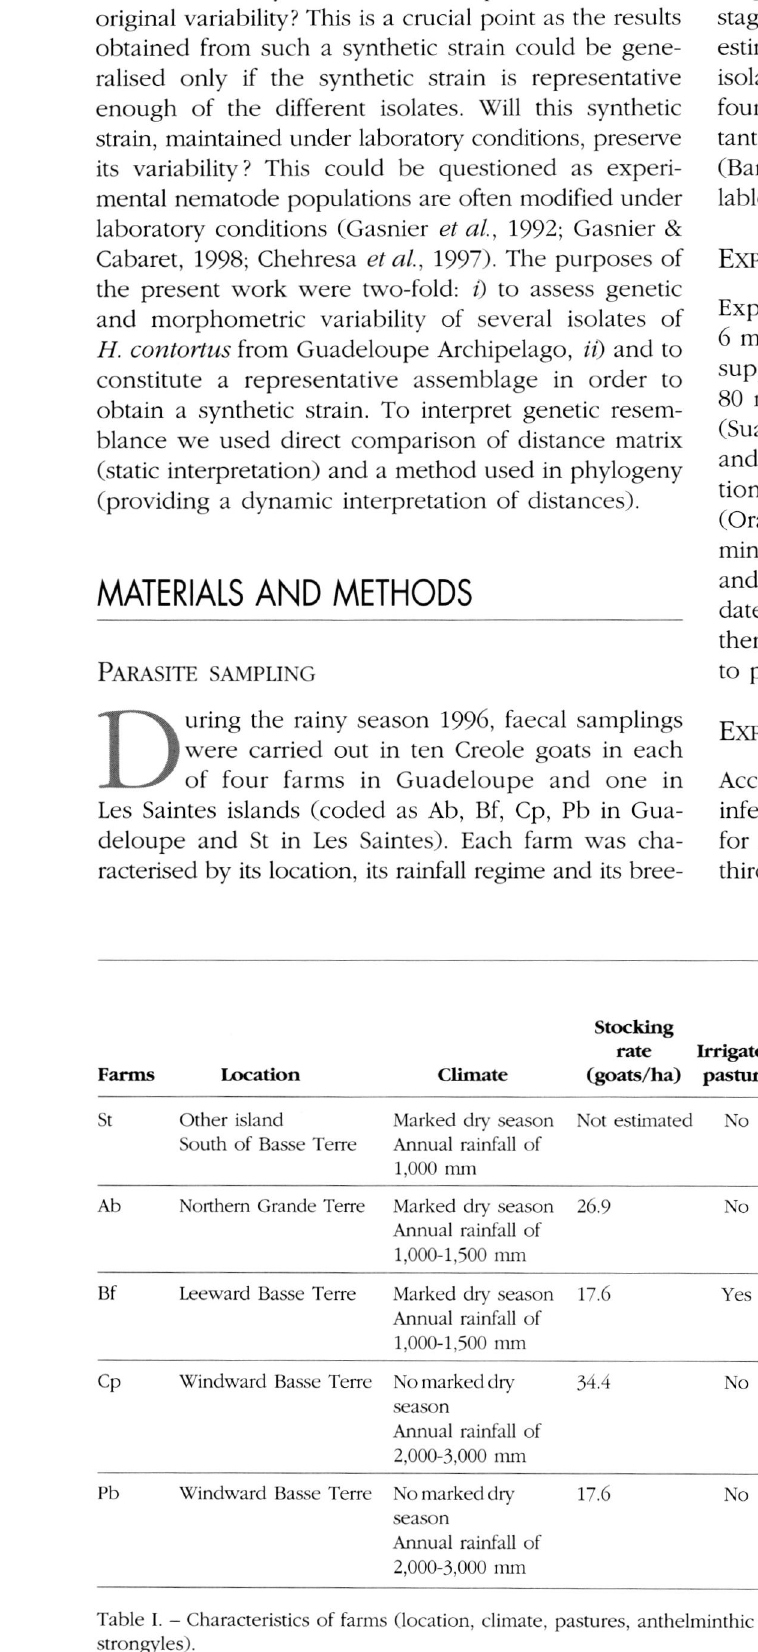
Table I. - Characteristics of farms (location, climate, pastures, anthelminthic treatments, animal breeding and main genera of digestive-tract strongyles).